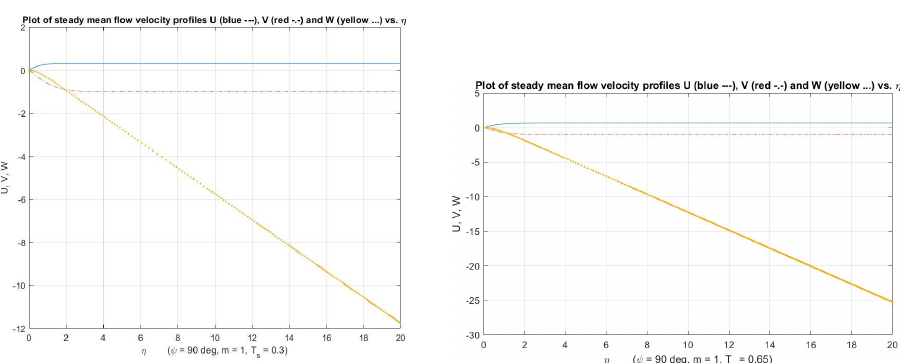
Figure 2. Plot showing the mean flow profile U , V and W for ψ = 90, T s = 0.30 ( left ) and 0.65 ( right ).